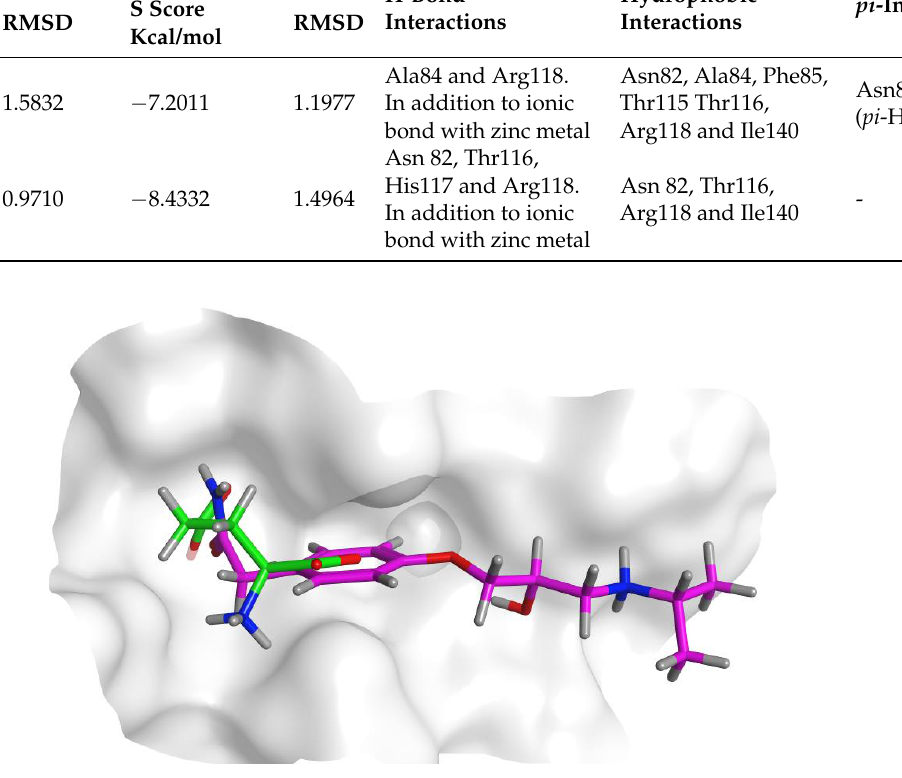
Figure 5. 3D alignment of Atenolol (Purple) and Glutamate (Green) in the binding pocket of MrpH showing the significant size difference.